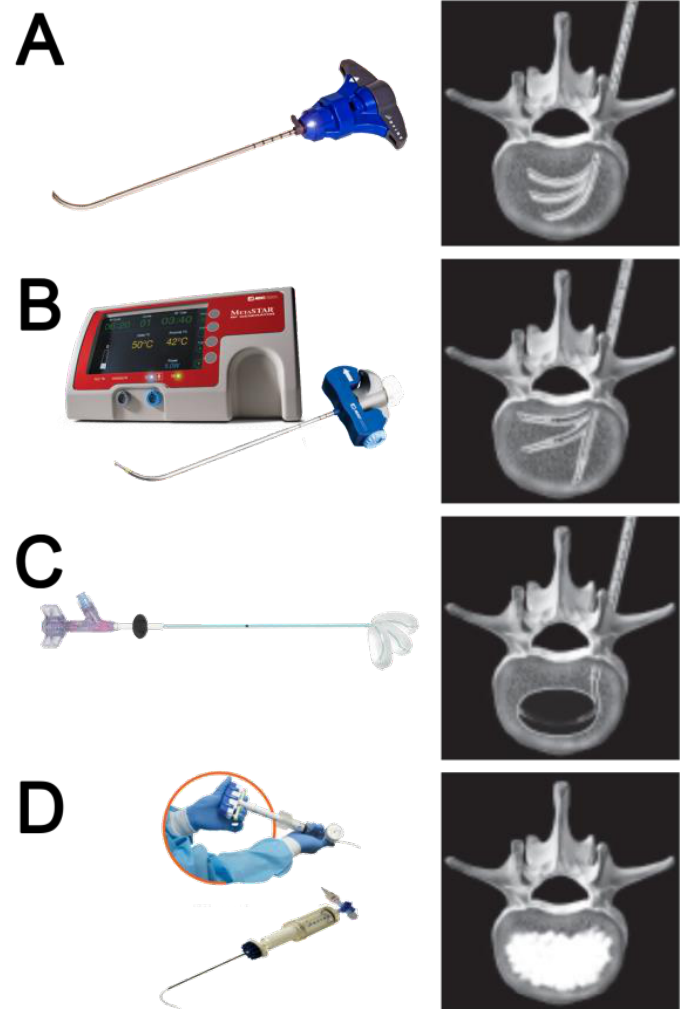
Figure 1. Procedural steps of RFA followed by cavity creation and cement augmentation with steer- able technologies. ( A ) Channel cavity creation with PowerCURVE ® : creation of preferential pathways into the spinal metastasis using the steerable osteotome for the following targeted placement of the RFA steerable STAR™ probe. ( B ) Targeted Radiofrequency Ablation with STAR™ probe: articulated bipolar probes allow trajectory changes within the vertebral body; thermocouples, embedded along the shaft, provide real-time feedback to quantify, adjust, and confirm the ablation zone. ( C ) Targeted cavity creation with Arcadia™: the Arcadia™ Steerable Balloon Catheter offers steerable technology to create a targeted cavity, with the intent of compacting the ablated tissue and create a void for cement delivery. ( D ) Vertebral Augmentation with StabiliT ® cement: high-viscosity bone cement with an extended working time of 35+ minutes, injected into the lesion with a hydraulic system providing controlled delivery. The median and interquartile ranges (IQR) for the VAS score (before RFA and 1 week, 1 month, 3 months, and 6 months after RFA) were calculated. The evolution of the VAS score was assessed during subsequent medical visits using the Wilcoxon test for paired samples. The distribution of FMS classification before and after RFA was assessed using McNemar’s test. Analyses were performed using R v4.0.2 statistical software, and p values < 0.05 were considered statistically